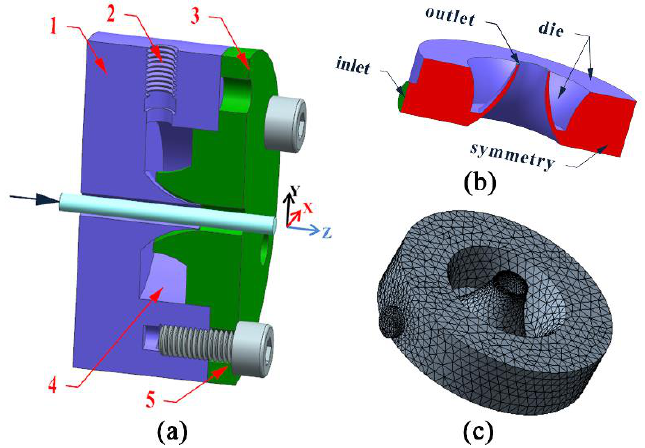
Figure 1. Geometric model and finite element model of the single chamber die. ( a ) Geometric model of the single-chamber gas-assisted die, 1—Connection module, 2—Gas inlet, 3—Die ring, 4—Single gas distribution chamber, 5—Connecting screw; ( b ) Geometry of the single gas distribution chamber; ( c ) Finite element mesh model of the single gas distribution